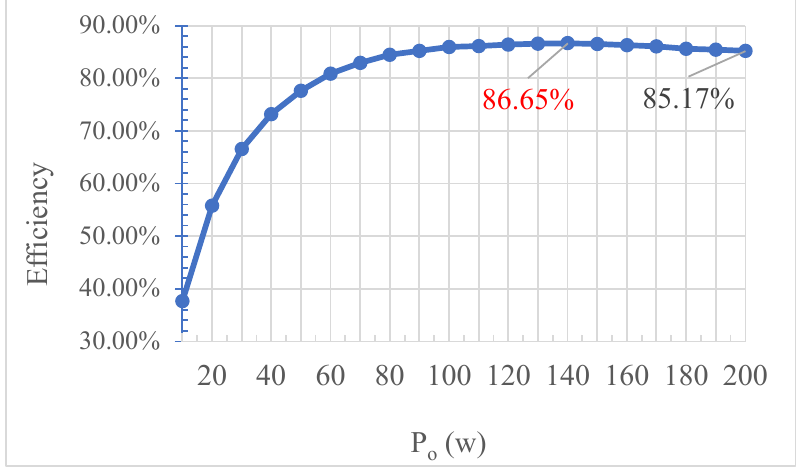
Figure 28. The efficiency curves of the proposed topology.